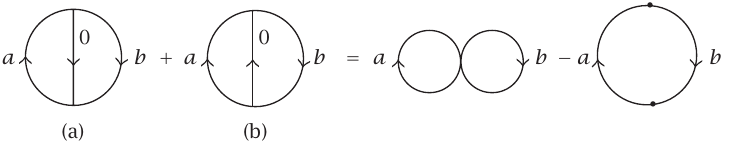
Figure 4.1 . Diagrammatic representation of the reflection identity.